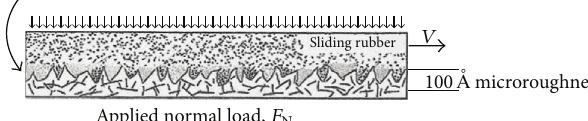
Figure 3: Rubber sliding at velocity 𝑉 on plate glass having a microroughness of 100 ˚A. The elastomer is compressed into the microstructure and densified by a normal load of 𝐹 N . Persson’s mechanism [5] is also depicted and considered to be a stratum of rubber self-adhering to portions of the glass surface, thereby generating a distinct frictional resistance